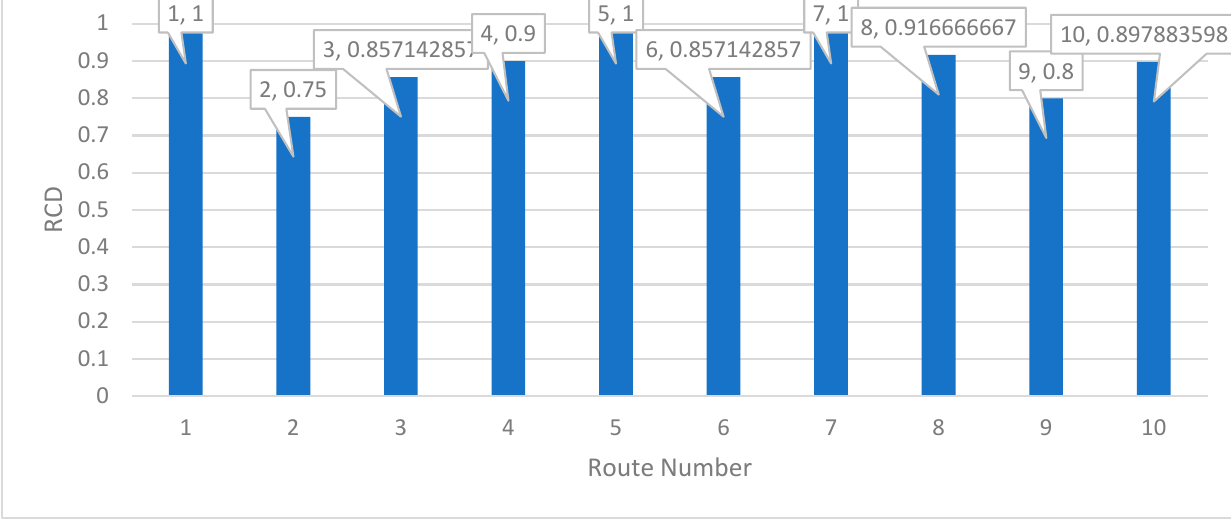
Figure 6. Performance comparison of proposed algorithm based on RCD values.